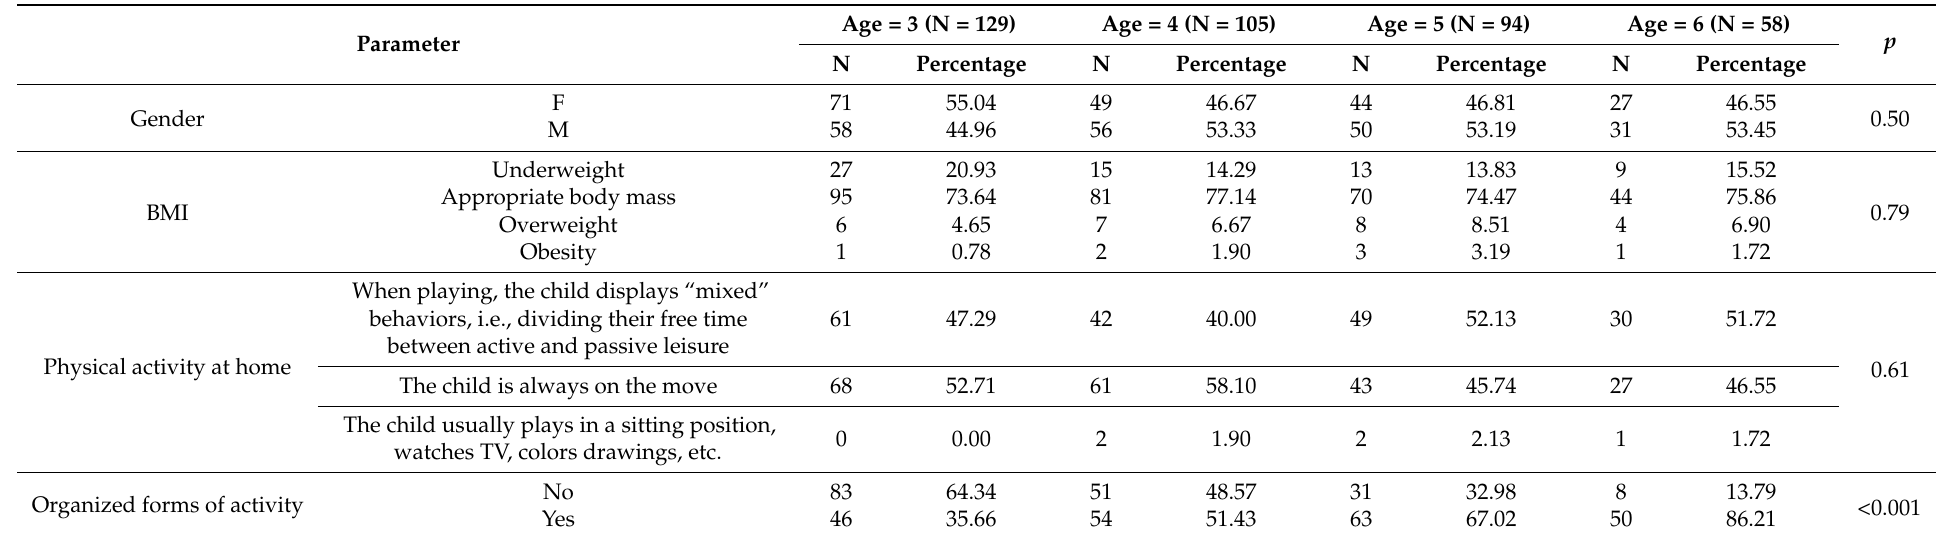
Table 3. Characteristics of the study group by